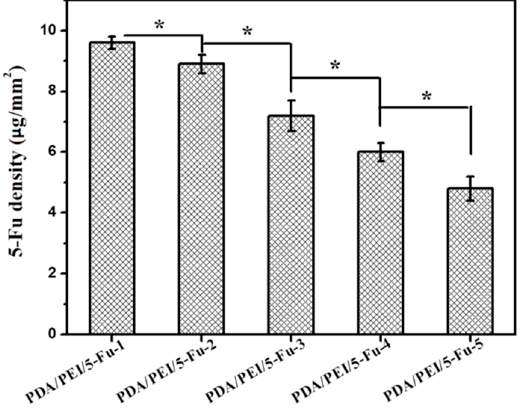
Figure 2. Surface 5-Fu density of PDA/PEI/5-Fu-1, PDA/PEI/5-Fu-2, PDA/PEI/5-Fu-3, PDA/PEI/5-Fu-4 and PDA/PEI/5-Fu-5 samples (* p < 0.05, mean ± SD, n =